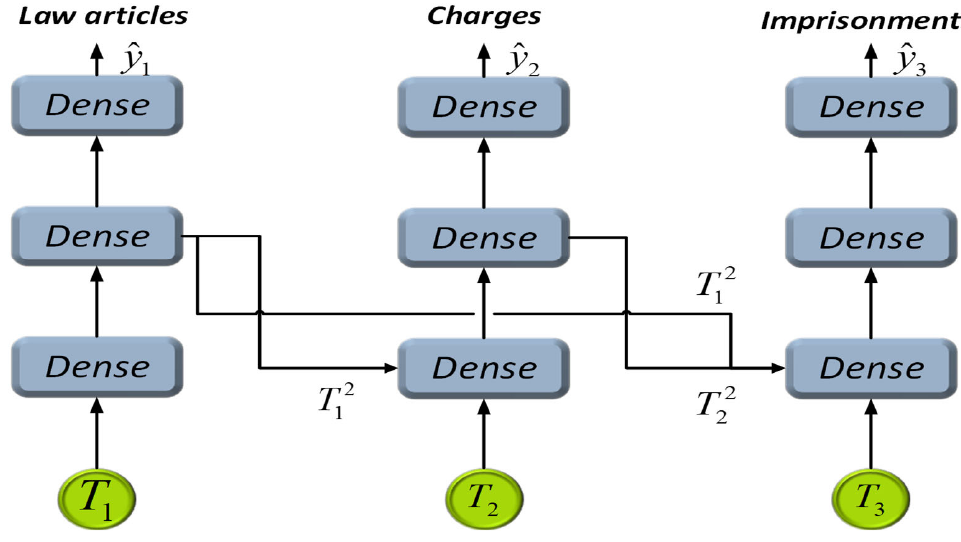
Figure 5. The specific structure of FTOPJUDGE.